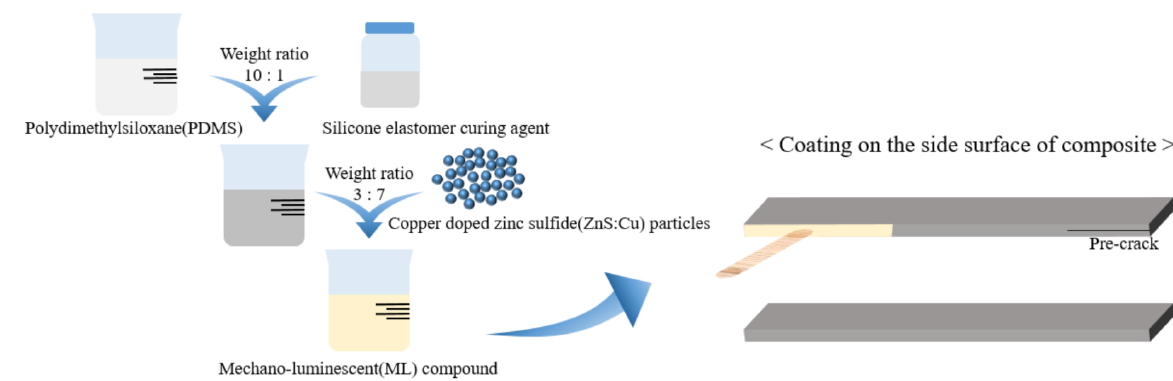
Figure 3. Fabrication of ML coated composite